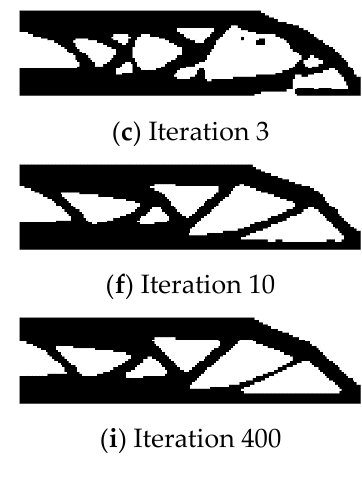
Figure 3. Optimization results at different stages.